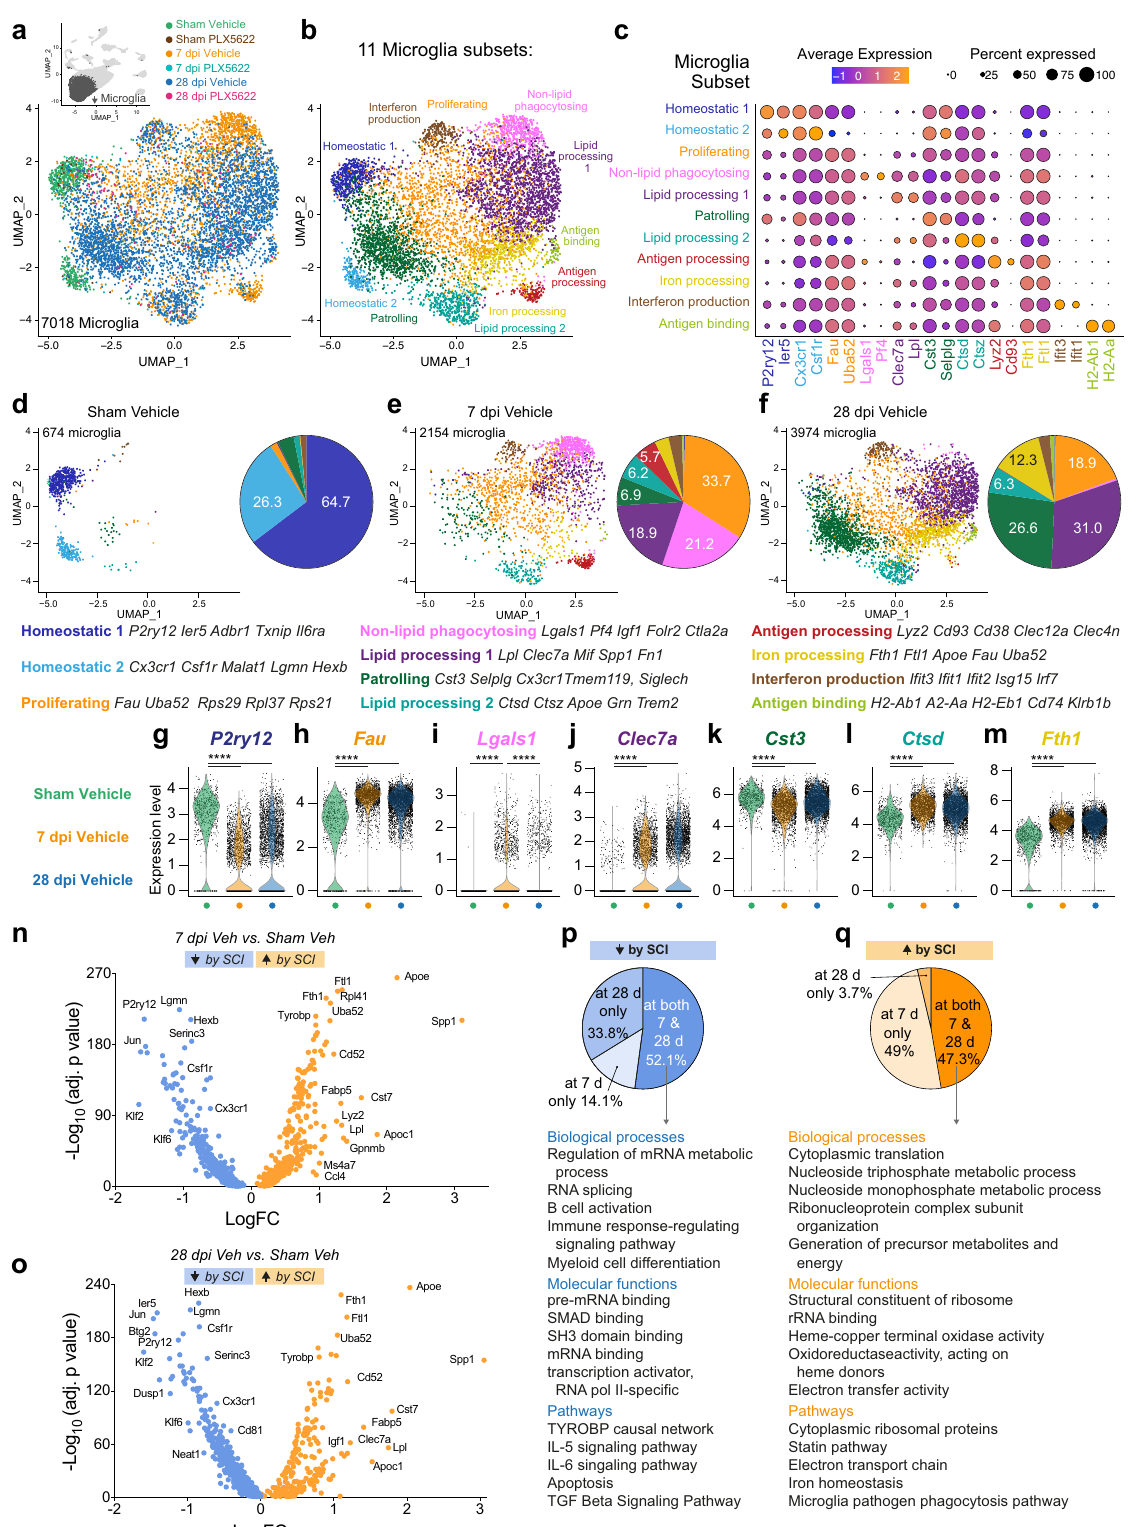
(Mac-1) 48 (Fig. 8b, e, h). At 28 dpi, in addition to abolishing microglia Psap interactions with astrocyte Gpr37l1, microglia depletion also disrupts astrocyte autocrine Psap-Gpr37l1 inter- actions and cadherin-cadherin (Cadm1) interactions important for astrogliosis and cell-cell adhesion (Fig. 8c, f, h). Considered with the scRNA-seq data, these communication maps